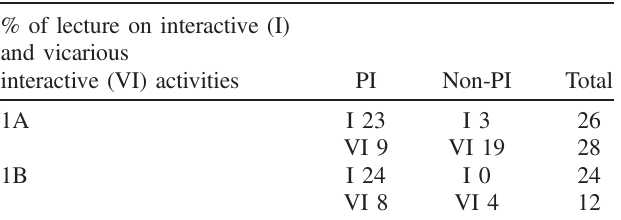
TABLE III. Interactivity in PI compared to non-PI sections of a